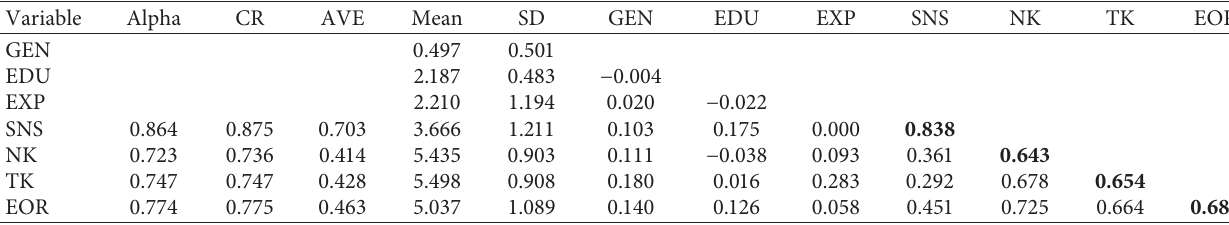
Table 2: Descriptive statistics, correlation matrix, reliability, and validity test.